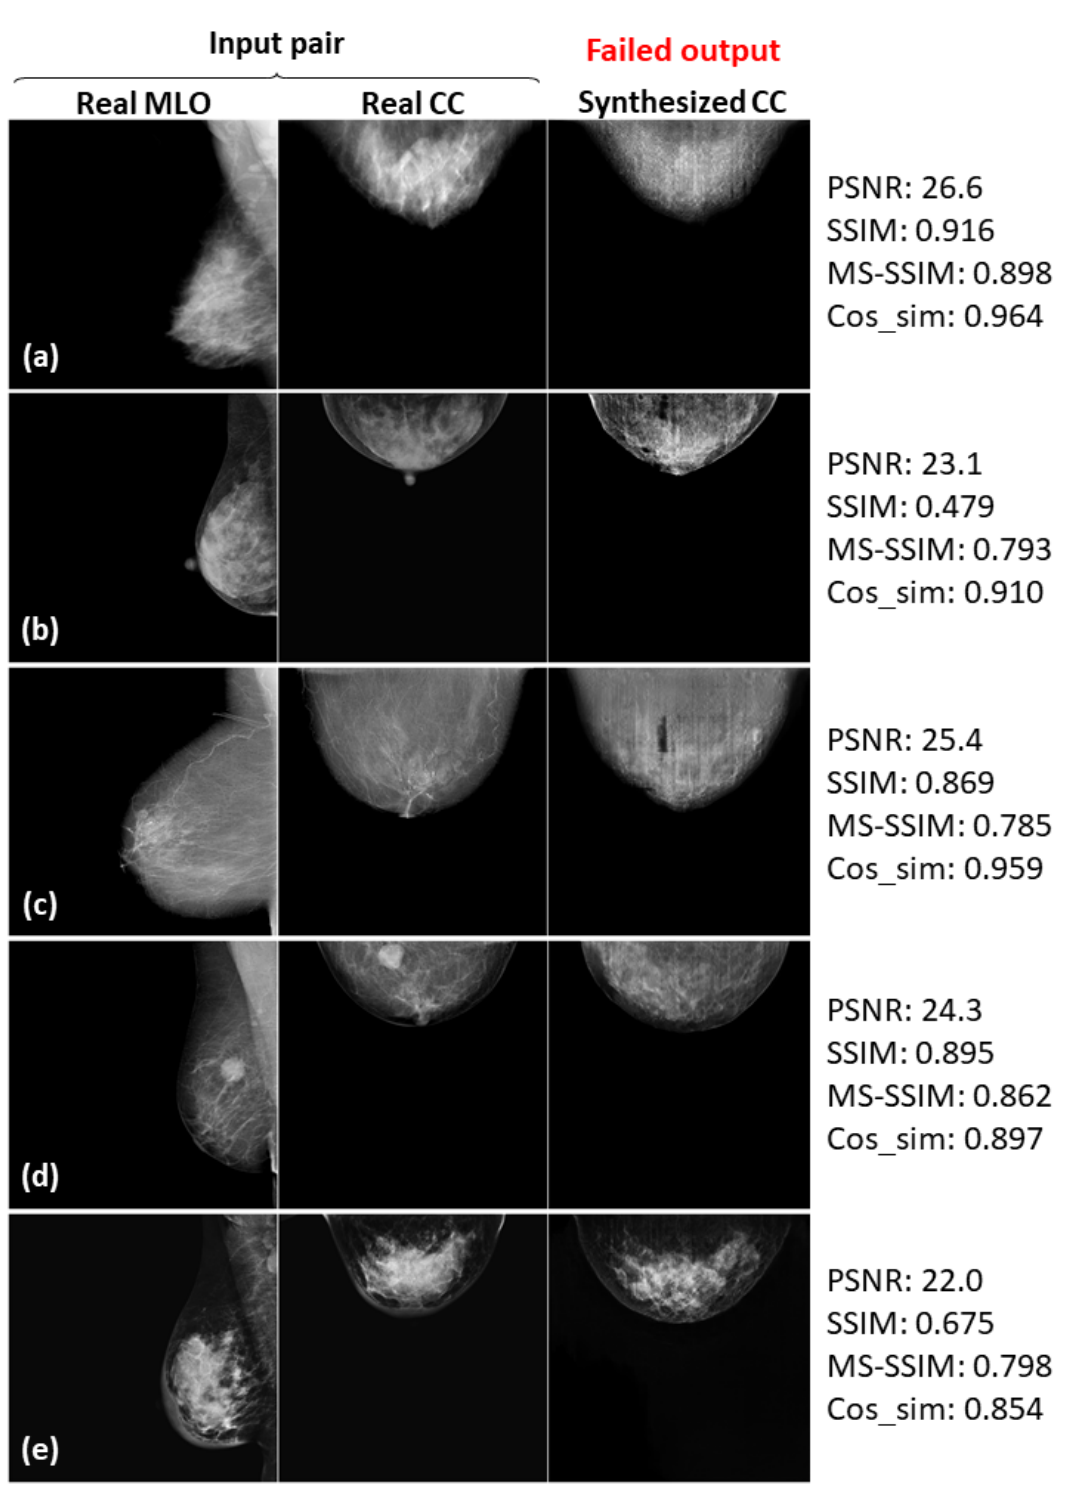
Figure 13. Five failed examples ( a – e ) of the real input paired and synthesized CC-view mammograms at 512 × 512 resolution by bi-directional training of CR-GAN incorporating PG technique and feature matching